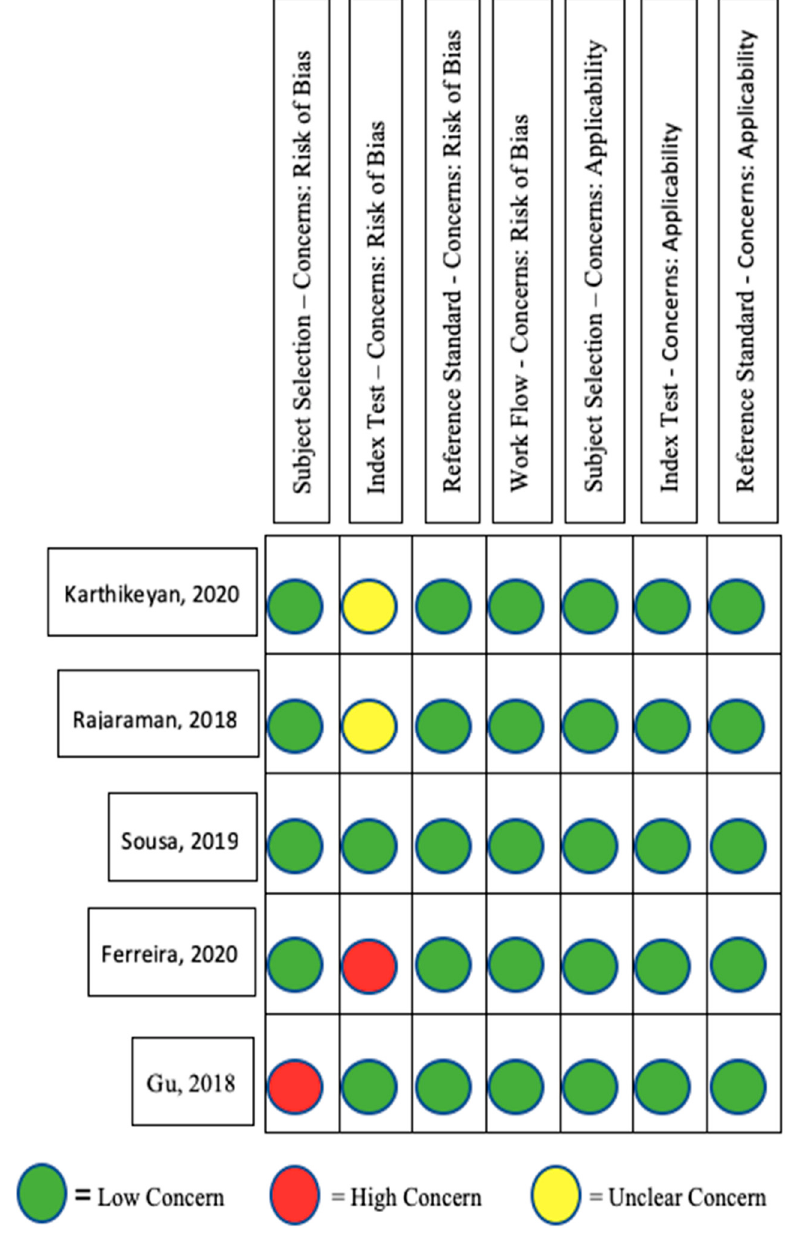
Figure 2. A risk of bias table of the five included studies from the adapted version of the QUADAS ‐ 2 ROB tool with a three ‐ point scale indicating low, high and unclear concern [5,44,49 – 51].